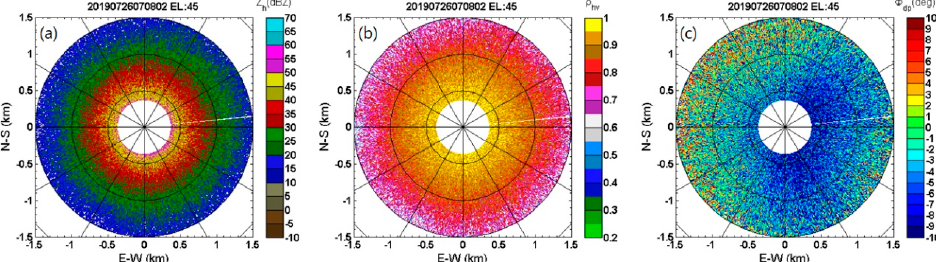
Remote Sens. 2019 , 11 , x FOR PEER REVIEW 12 of 15 Figure 15. Rainfall observation image of EWRG (2019/07/26 07:08:02, Yeoncheon). ( a ) Reflectivity (Z h ); Figure 15. Rainfall observation image of EWRG (2019 / 07 / 26 07:08:02, Yeoncheon). ( a ) Reflectivity (Z h ); ( b ) Correlation Coefficient ( ρ hv ); ( c ) Differential Phase Shift ( Φ dp ). ( b ) Correlation Coe ffi cient ( ρ hv ); ( c ) Di ff erential Phase Shift ( Φ dp ).